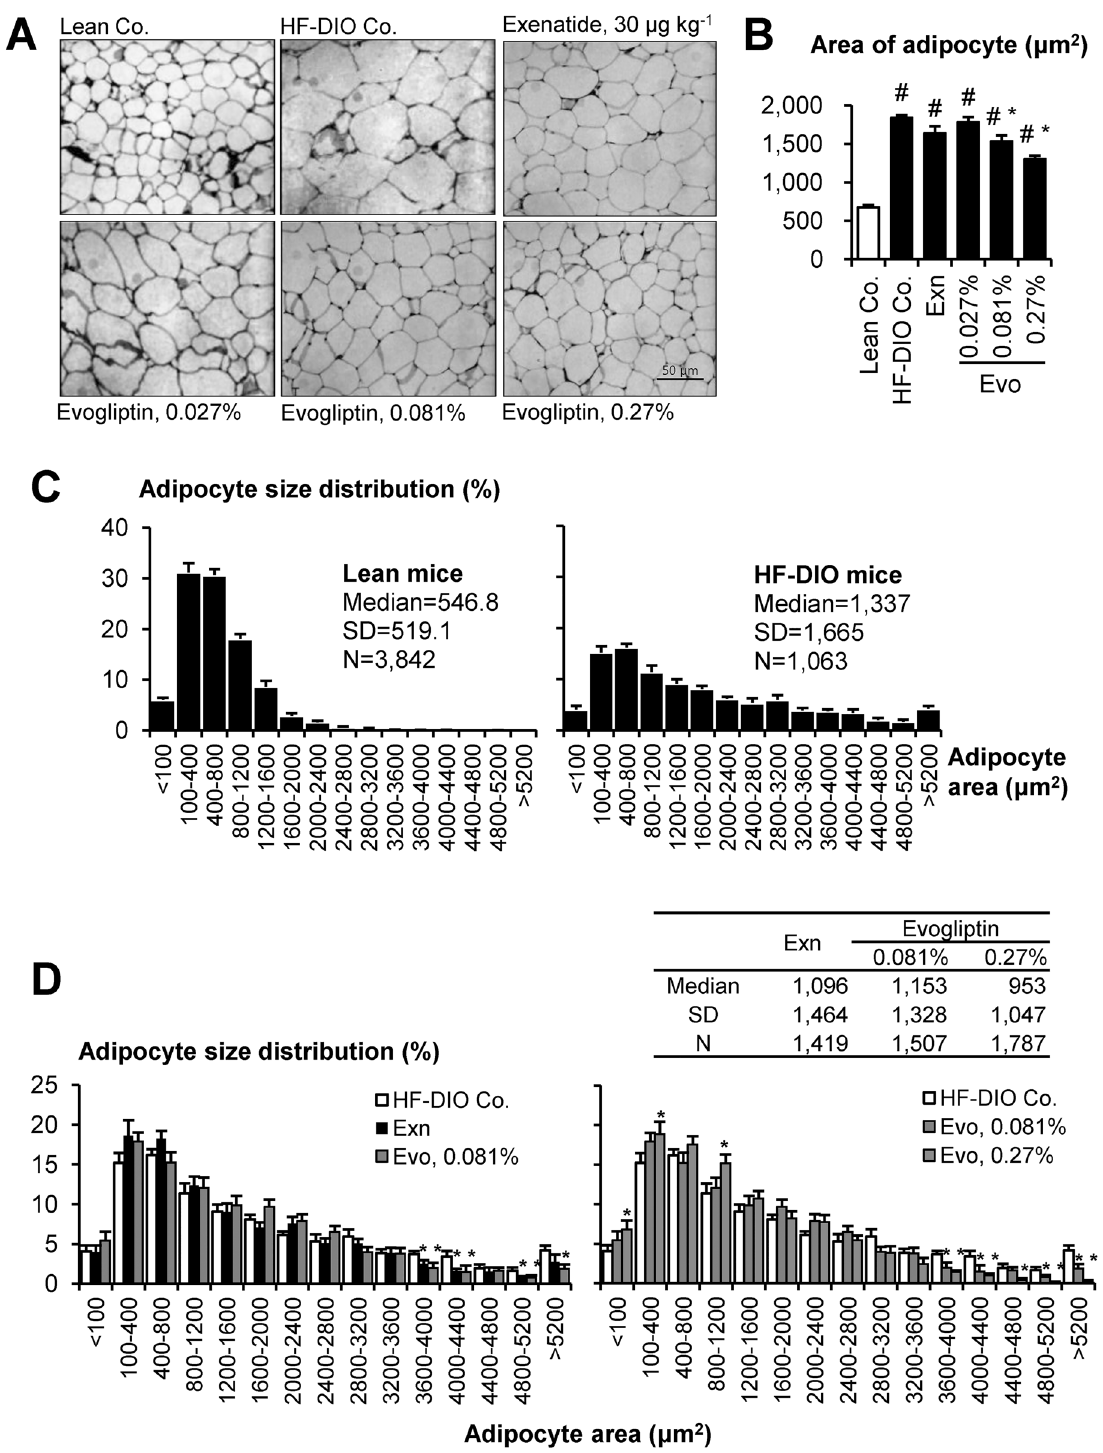
Fig 3. Evogliptin treatment reduced adipocyte size and distribution. HF-DIO mice were treated with exenatide (30 μ g kg -1 , once daily, s.c.) or evogliptin at 0.027%, 0.081%, or 0.27% (w/w) for 2 weeks. The effects on adipocytes from epididymal fat tissues were histologically determined (three sections/ animals, eight animals/group). (A) Representative images (original magnification, ×200), (B) mean adipocyte areas and (C-D) percentile distribution of adipocyte size were presented. #, P < 0.05 vs. lean control and * , P < 0.05 vs. HF-DIO control by one-way ANOVA.